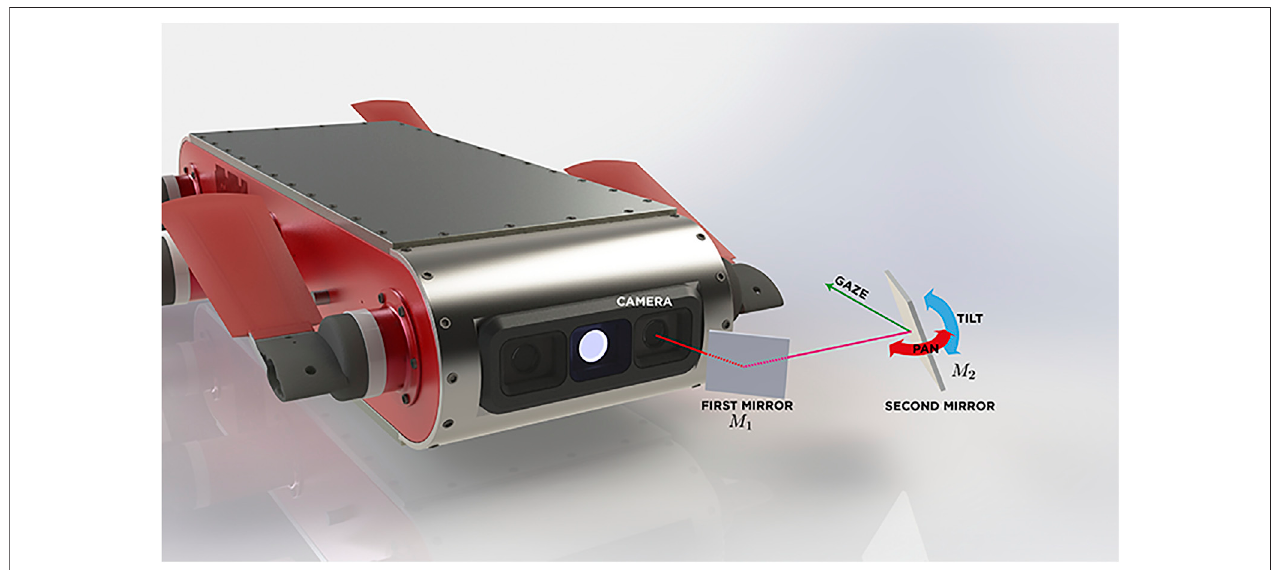
FIGURE 2 | A two-mirror system design interacting with the AUV ’ s camera.